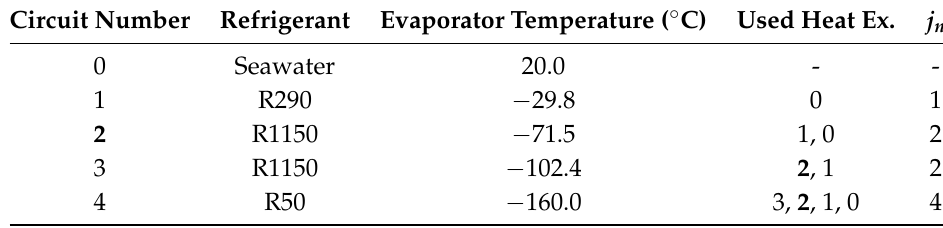
Table 1. Optimized configuration of 1-2-1-Cascade. Heat Exchanger Number 2 is used as the condenser for Refrigerant Cycle 3 and as gas cooler for Cycle 4 as illustrated with boldface numbers